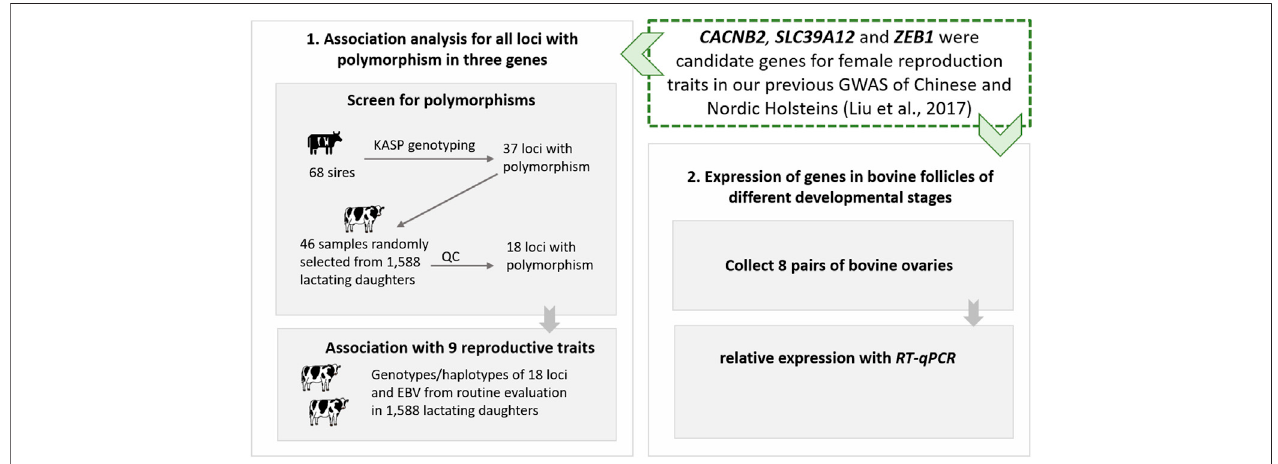
FIGURE 1 | The designed technology route of post-GWAS functional analysis for gene CACNB2 , SLC39A12 and ZEB1 in Holstein